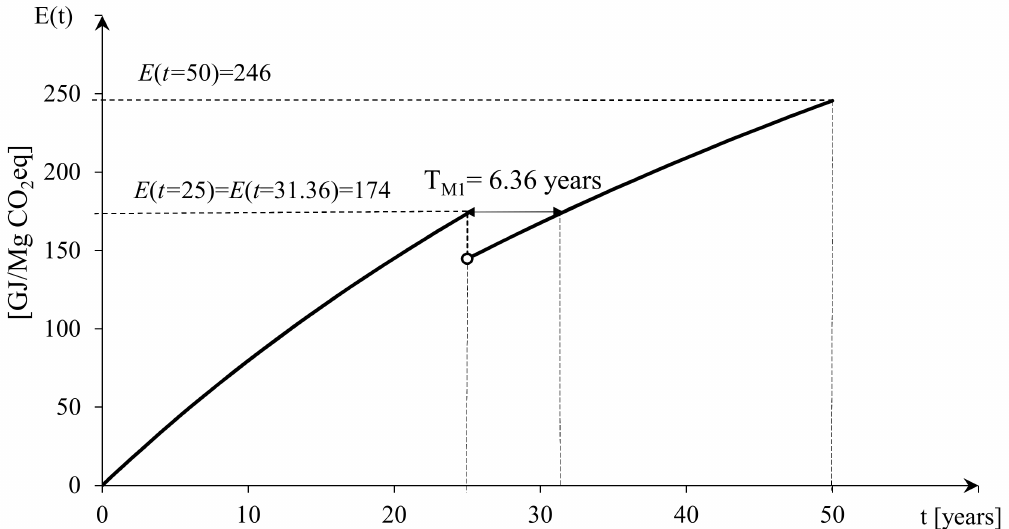
Figure 5. A graphical interpretation of the integrated ecological e ffi ciency indicator from CO 2 emissions for a wind power plant undergoing modernization during a 50-year period of